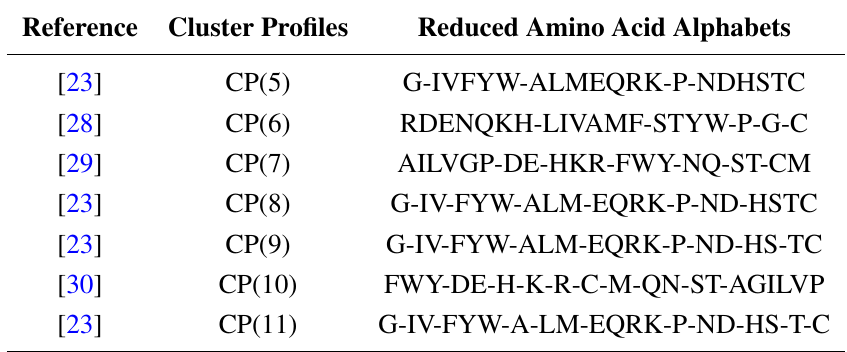
Table 7. Scheme for the reduced amino acid